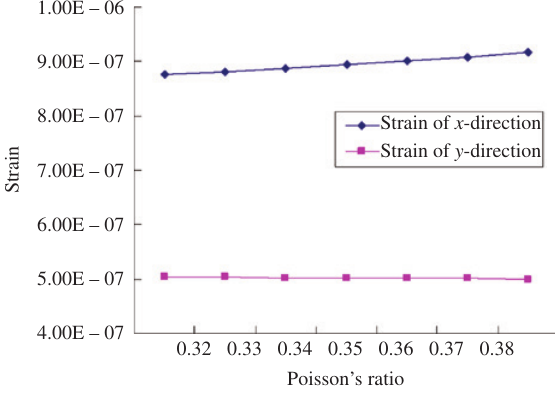
Figure 9: Relationship between polymer phase Poisson’s ratio and strain of composite material ( U = 10 V).